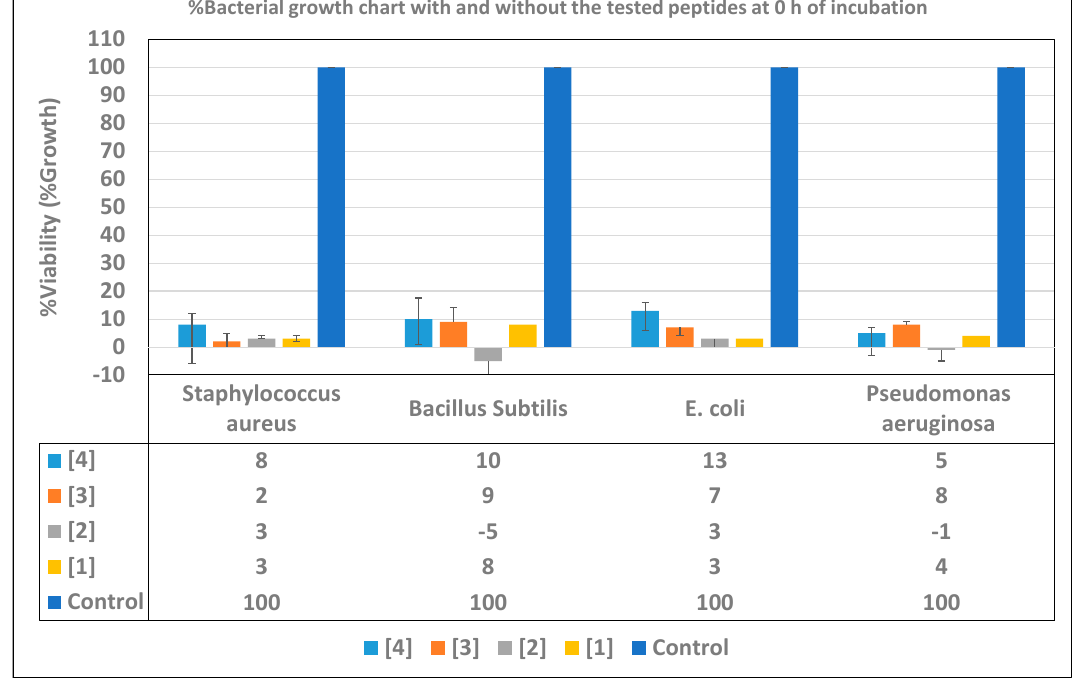
Figure 4. The growth percentage chart of the bacteria in the presence of the newly-synthesized AMPs, compared with the negative controls before the incubation (at 0 h of incubation).